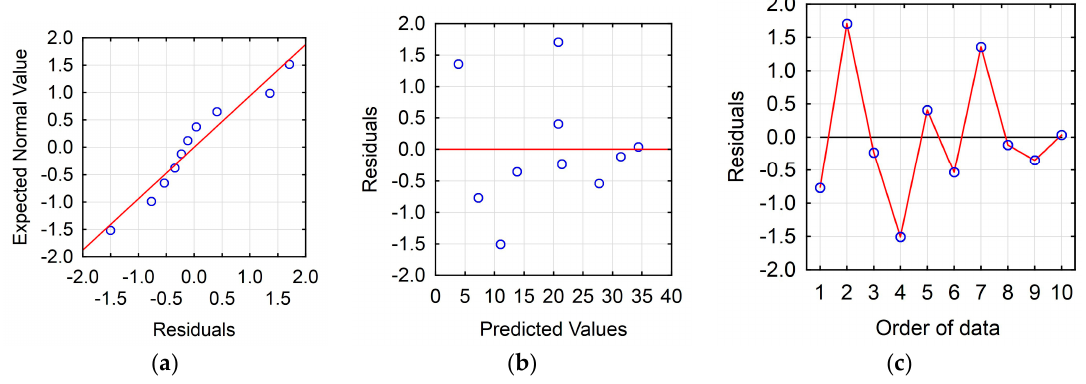
Figure 10. Plots for check model of average white layer thickness: ( a ) normal plot of residuals; ( b ) the residuals versus the predicted values; ( c ) the residuals versus the order of the data.